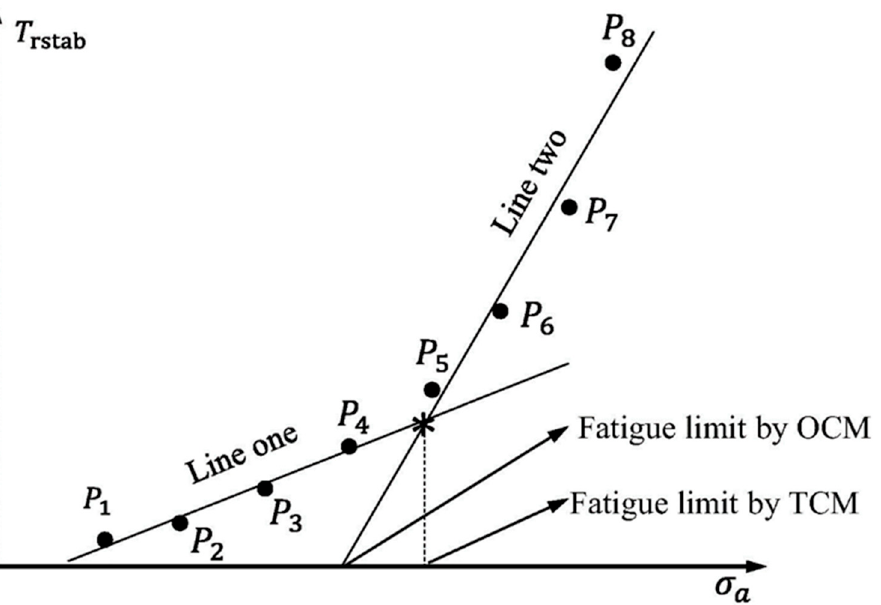
Figure 20. A schematic illustration of fatigue limit prediction using energy-based Risitano’s and Luong’s models [81].